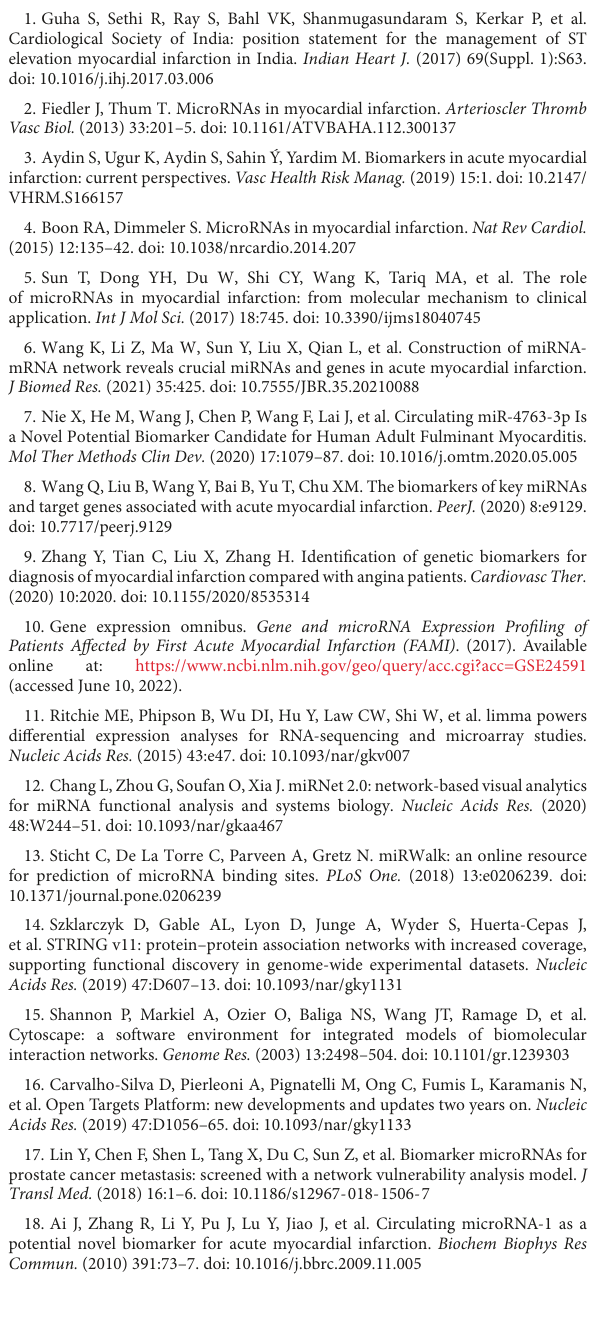
SUPPLEMENTARYFIGURE1 A representative image of the PPI interaction network for the predicted target genes. Colored nodes (circles) indicate direct/first line interactions among the genes. Purple and blue color lines denote known interactions determined experimentally and from curated databases, respectively. Black, dark green and light green lines indicate co-expression, neighborhood gene and interactions derived from text mining, respectively. Thickness of the lines indicates strength of data support.